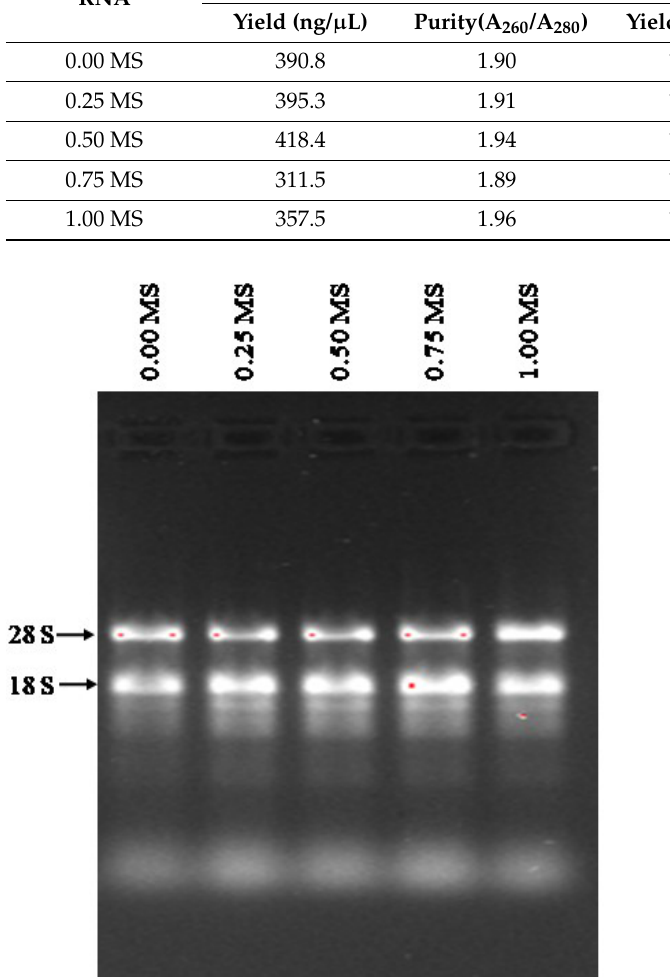
Table 9. Yield and purity of RNAs extracted from leaves of stevia. Before DNAse I Treatment RNA